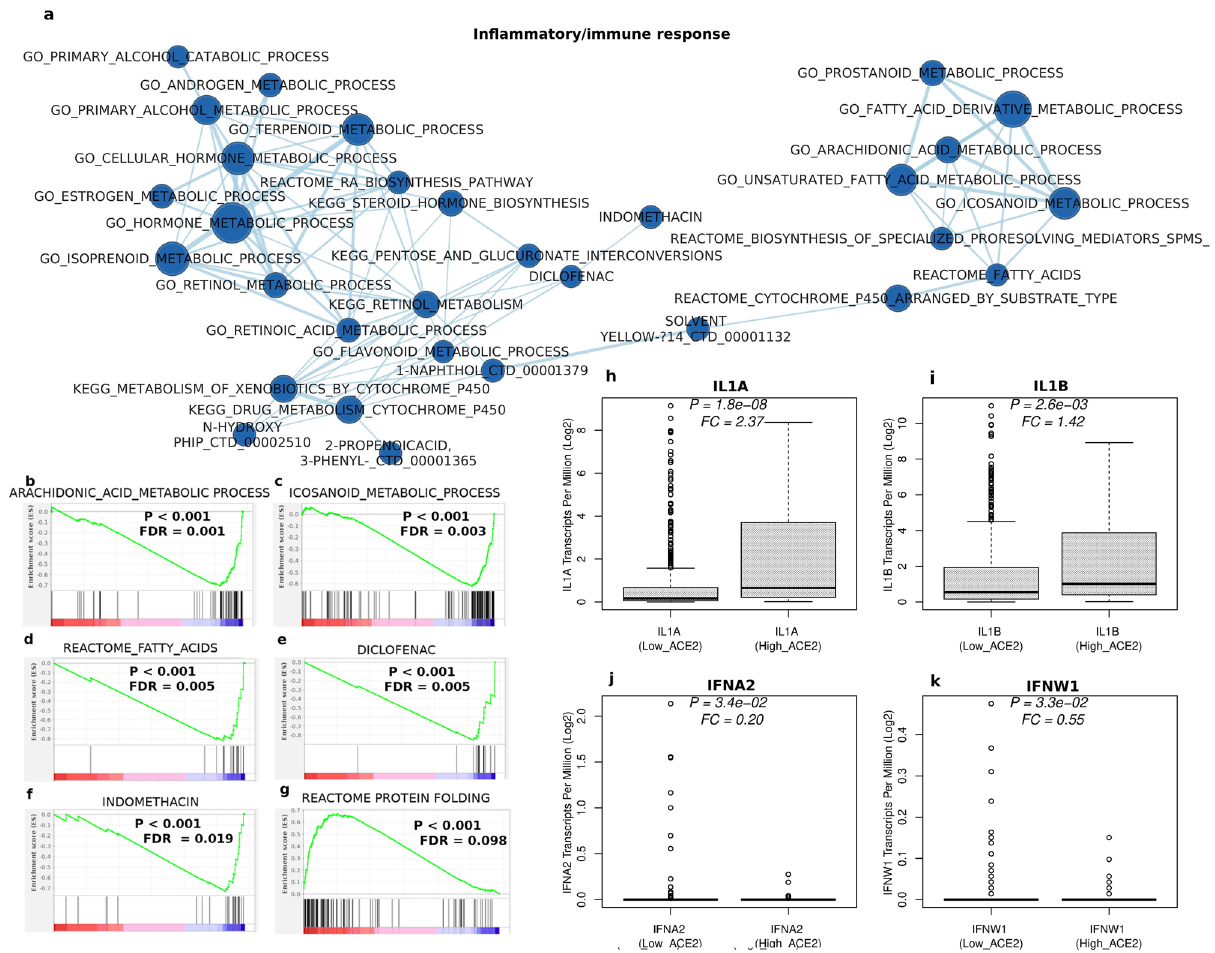
Figure 2. ACE2 overexpressing cell lines mimic host immune response in COVID-19 severe infection. ( a ) Network built from differentially expressed datasets related to a hyperinflammatory/immune response obtained by the Gene Set Enrichment Analysis (GSEA) of Low_ACE2 vs. High_ACE2 expressing cell lines. Datasets overexpressed ( b – f ) or underexpressed ( g ) in High_ACE2 cell lines. Vertical bars represent where the members of the gene set appear in the list of ranked genes. Genes are ranked on the base of their differential expression in ’Low_ACE2’ vs. ’High_ACE2’ samples, with genes decreasingly overexpressed in ’Low_ACE2’ samples starting from the left of the graph. IL1A ( h ), IL1B ( i ), IFNA21 ( j ) and IFNW1 ( k ) expression in Low_ACE2 vs High_ACE cell lines. FC: expression ratio of High_ACE2 vs. Low_ACE2 cell lines. FC: expression ratio of each transcript in High_ACE2 vs. Low_ACE2 cell lines. Values around the median in ( j ) and ( k ) are compressed toward the bottom because they possess mostly a zero